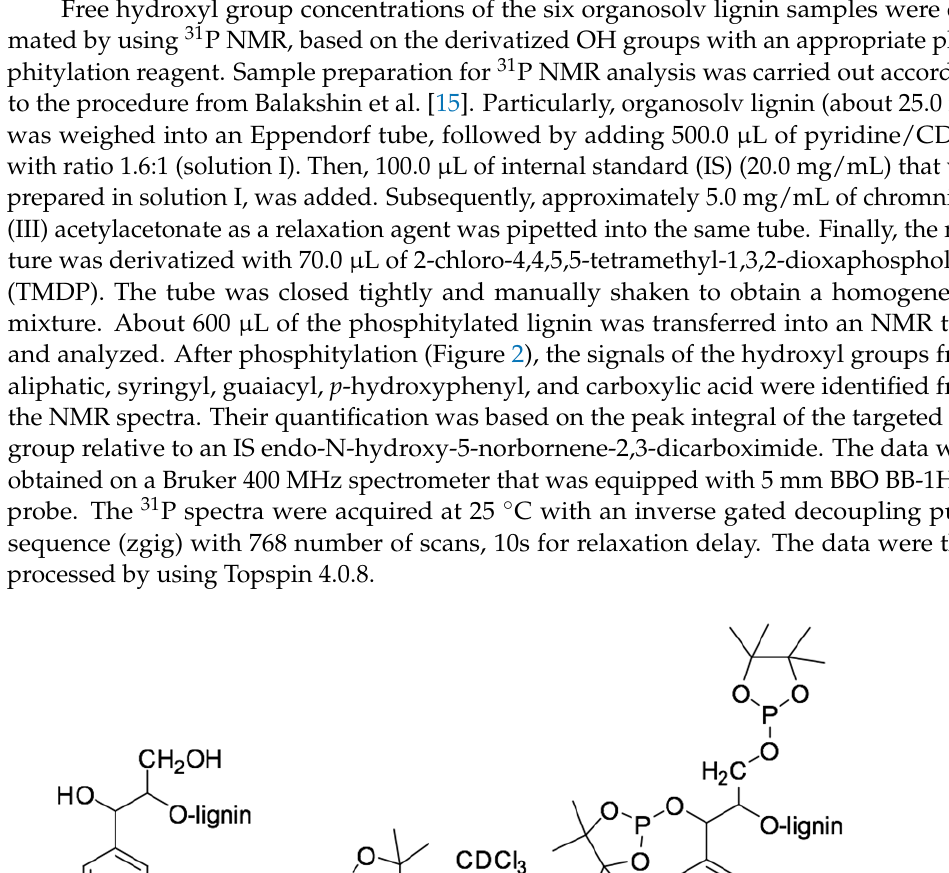
All the 31 P spectrum were calibrated by the signal from IS at 151.8 ppm; and the inte- gration as well as assignment were based on the study by Balakshin et al. [15].